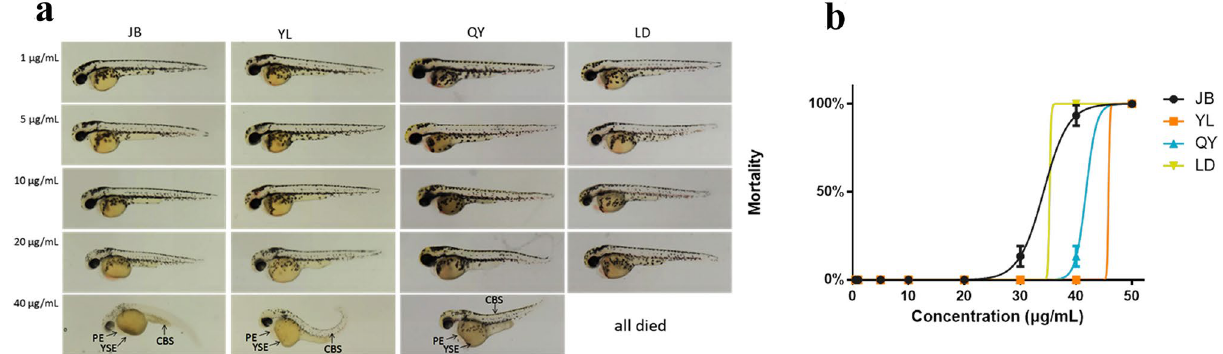
Figure 6. The toxicity of thyme oils in zebrafish larvae ( a ). Mortality curves until 48 hpf ( b ). Results are presented as means ± SD ( n = 15). YSE: yolk sac edema; PE: pericardial edema; CBS: curved body shape.